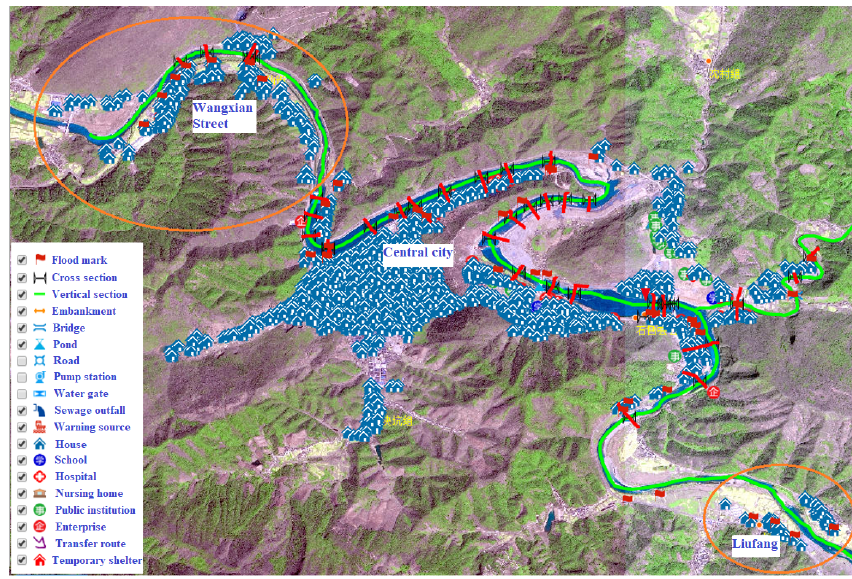
Figure 4. Distribution diagram of Shitai mountain flood impact survey and measurement (map data © MapWorld Anhui, http://anhui.tianditu. gov.cn, last access: August